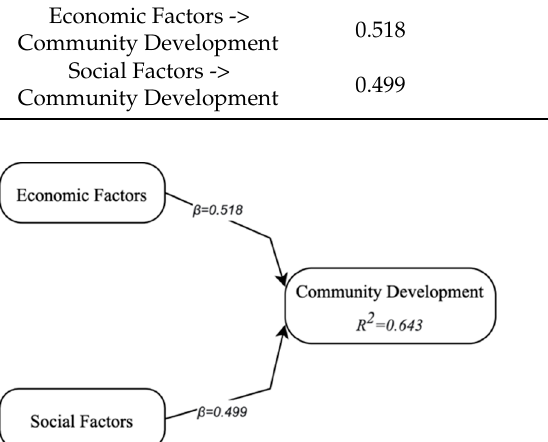
Table 6. Path coefficient of the model.